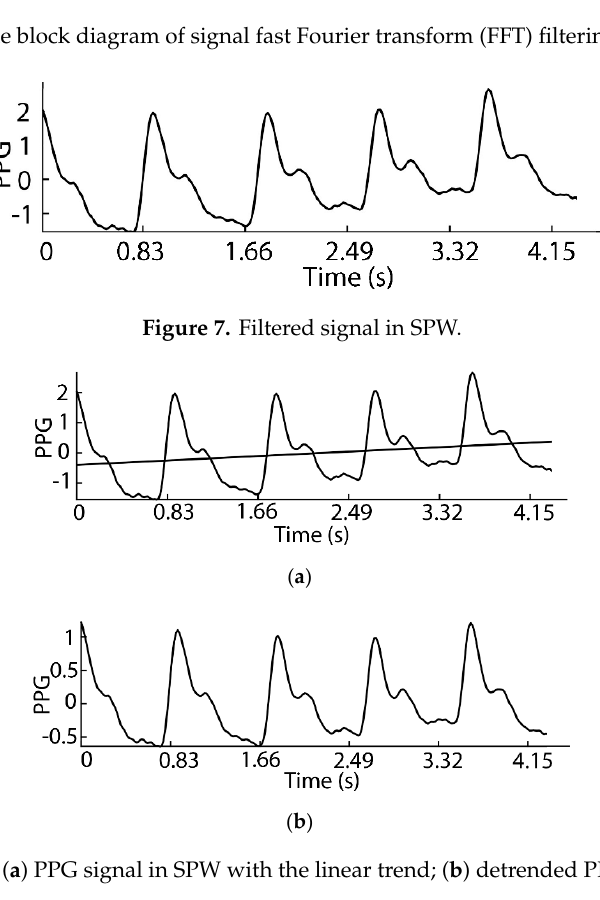
Figure 8. ( a ) PPG signal in SPW with the linear trend; ( b ) detrended PPG